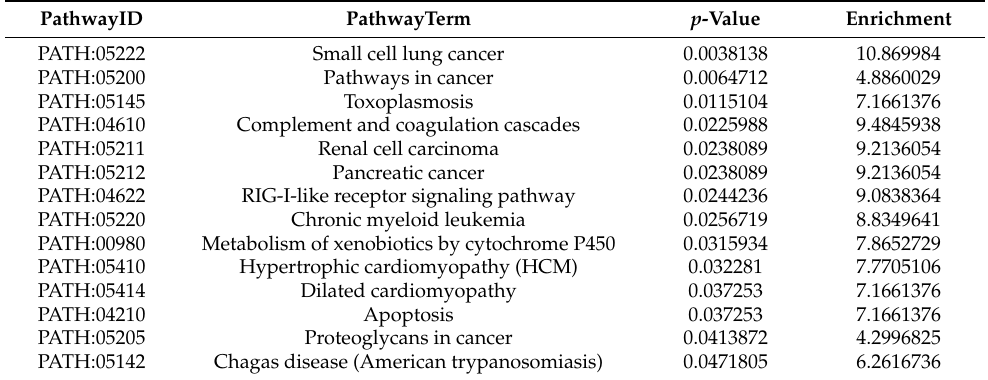
Table 2. KEGG enrichment of up-regulated DEGs show the significantly enriched pathways. The data are ranked according to the p -Value, which indicates the degree of enrichment.